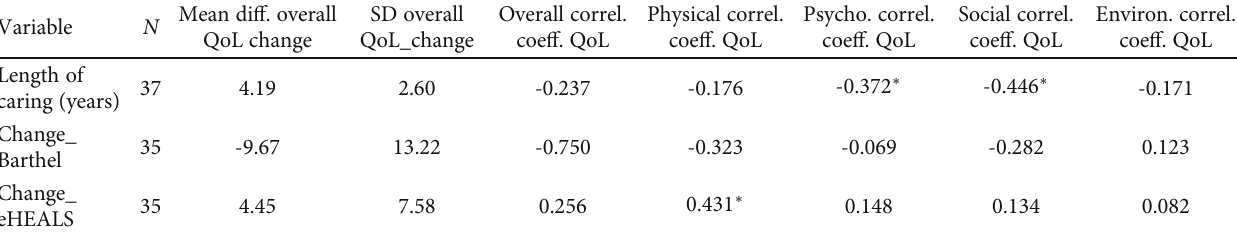
Table 5: Correlations between quantitative caregivers ’ variables and